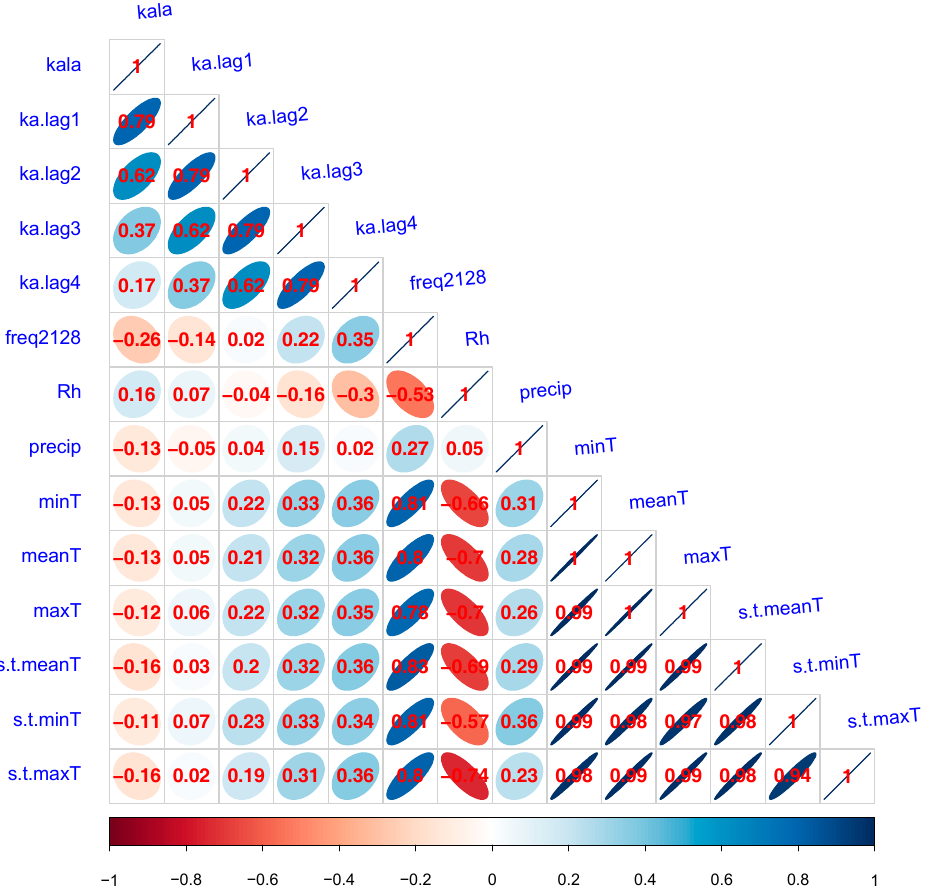
Figure 2. Correlation matrix of VL and meteorological factors. Size and color indicate the magnitude of positive or negative correlation coefficients.